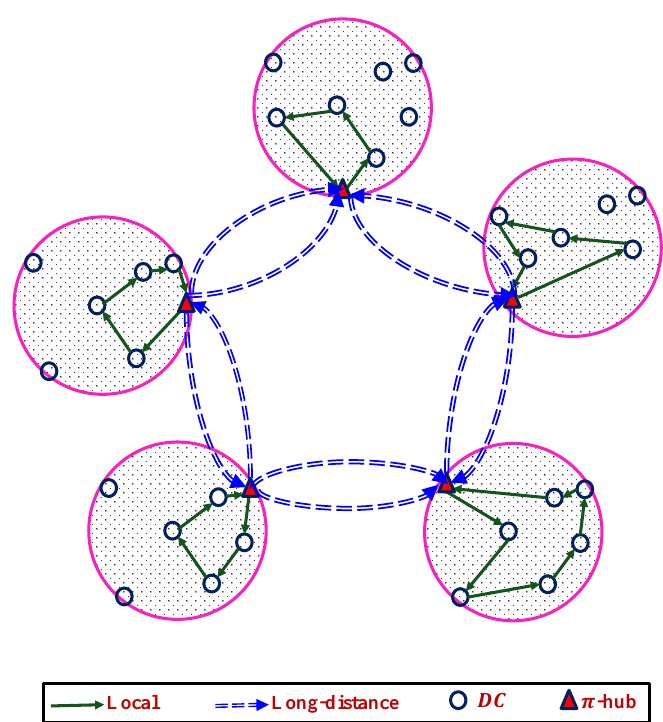
Figure 6. Integration of local and long-distance food